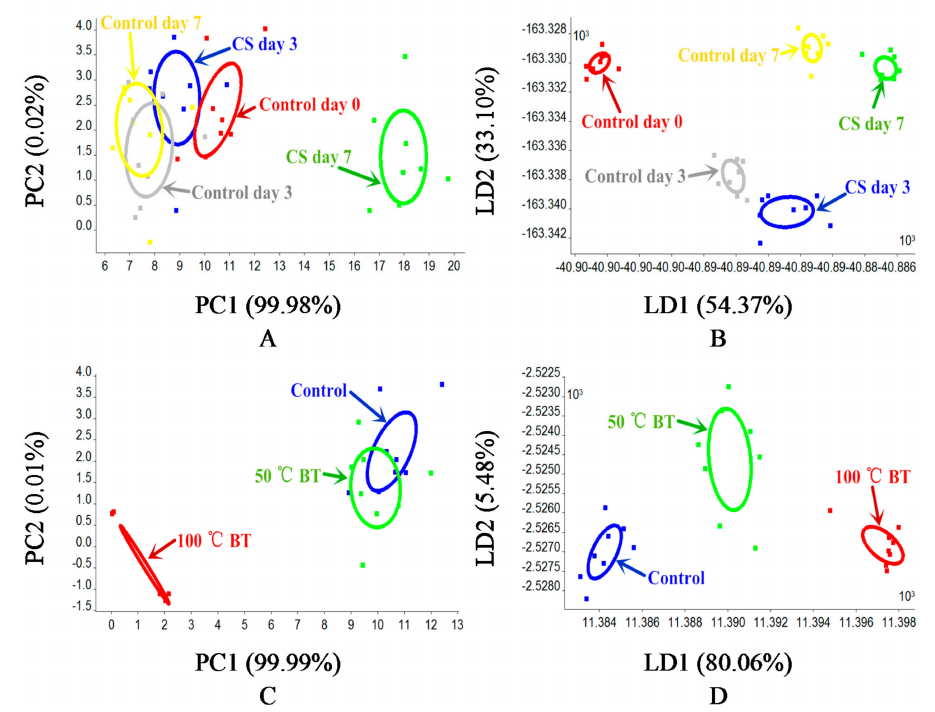
Figure 4. PCA and LDA classification for different postharvest handling treatments of tomatoes based on E-nose. ( A ) PCA for CS tomatoes, ( B ) LDA for CS tomatoes, ( C ) PCA for BT tomatoes, ( D ) LDA for BT